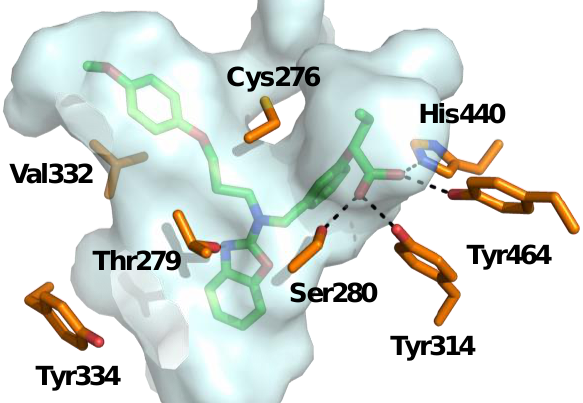
Figure 6. Pemafibrate (green) co-crystallized with PPARα. Binding pocket indicated with gray surface and interacting amino acids depicted in orange (PDB ID: 6L96).